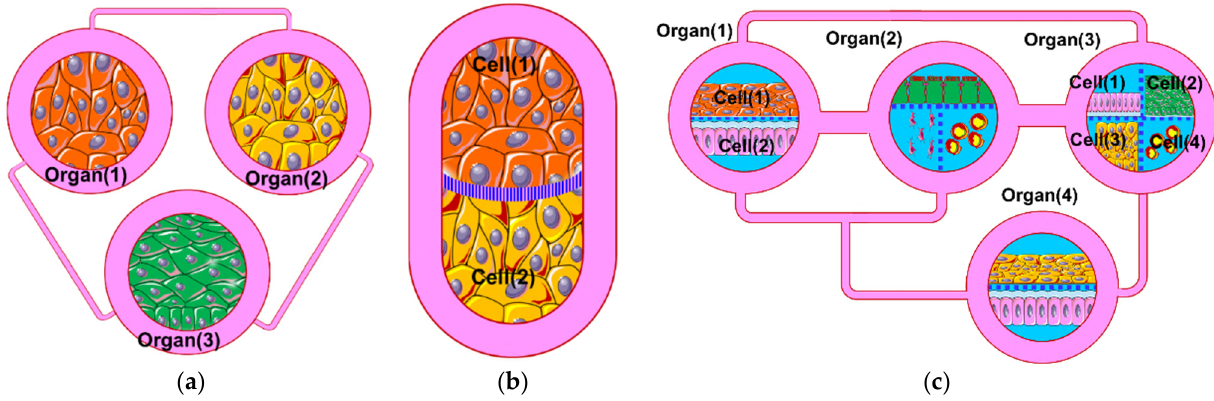
Figure 1. Three strategies of mOOC perfusion systems. ( a ) Individual tissue models (OOCs) linked together through microchannels or tubing. ( b ) Two (or more) tissue models (OOCs) interfaced through a thin, porous barrier (e.g., porous membrane). ( c ) Several organ models linked together through tubing. Each organ model comprises two or more cell types interfaced through thin, porous barriers.